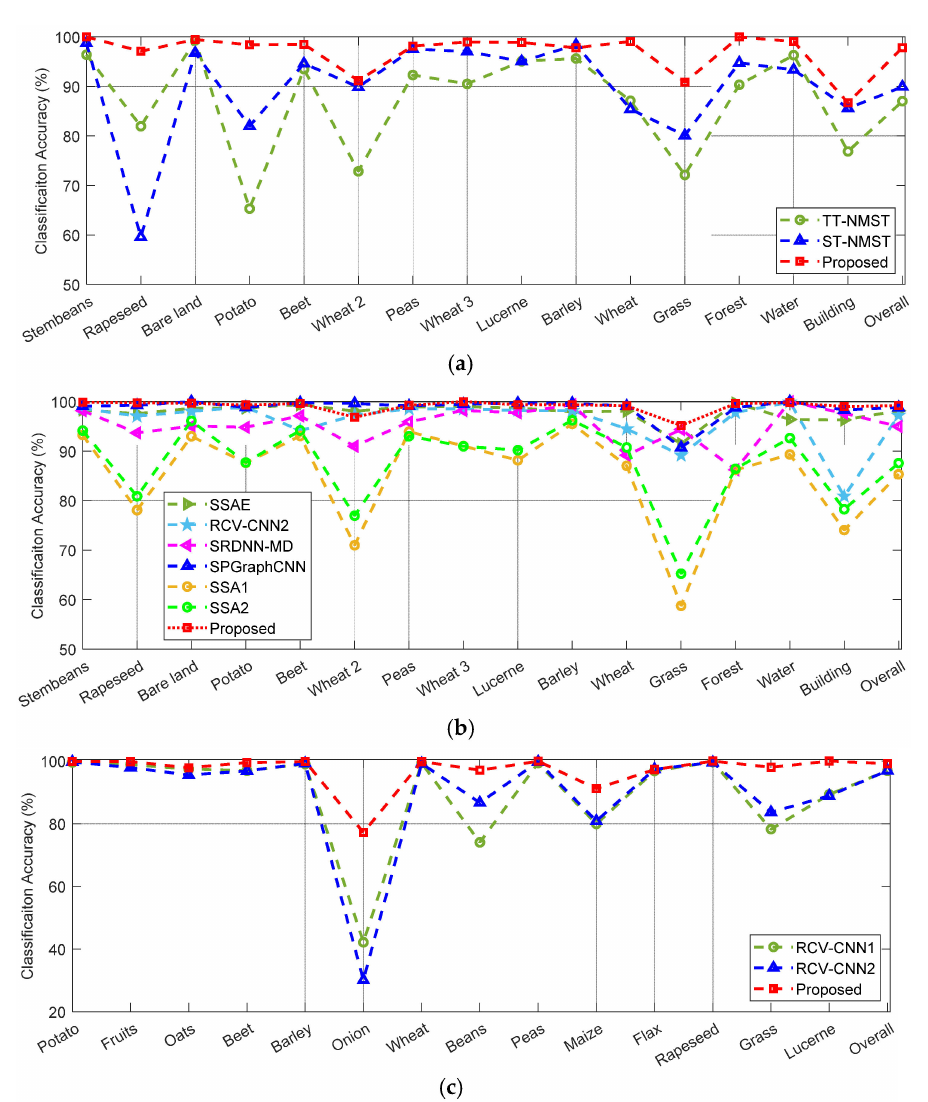
Figure 12. Classification accuracy values obtained by different methods, corresponding to those given in ( a ) Table 2, ( b ) Table 3 and ( c ) Table